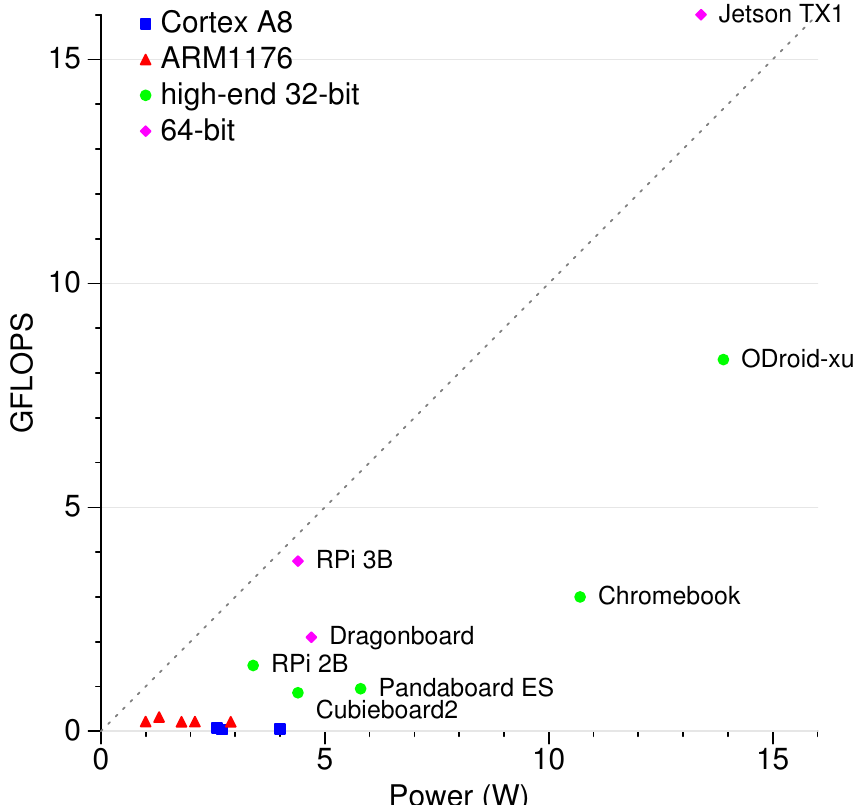
Figure 1. Performance (GFLOPS) compared to average power. Upper left is the